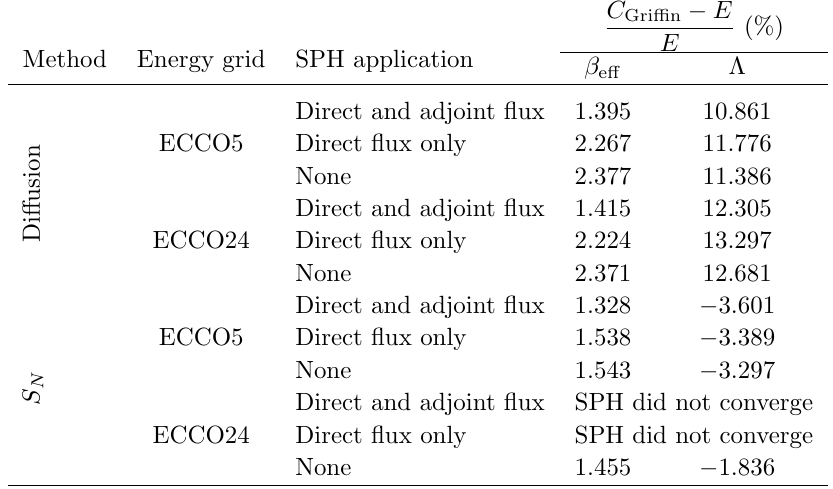
Table 17. Relative differences between Griffin and Godiva benchmark kinetics